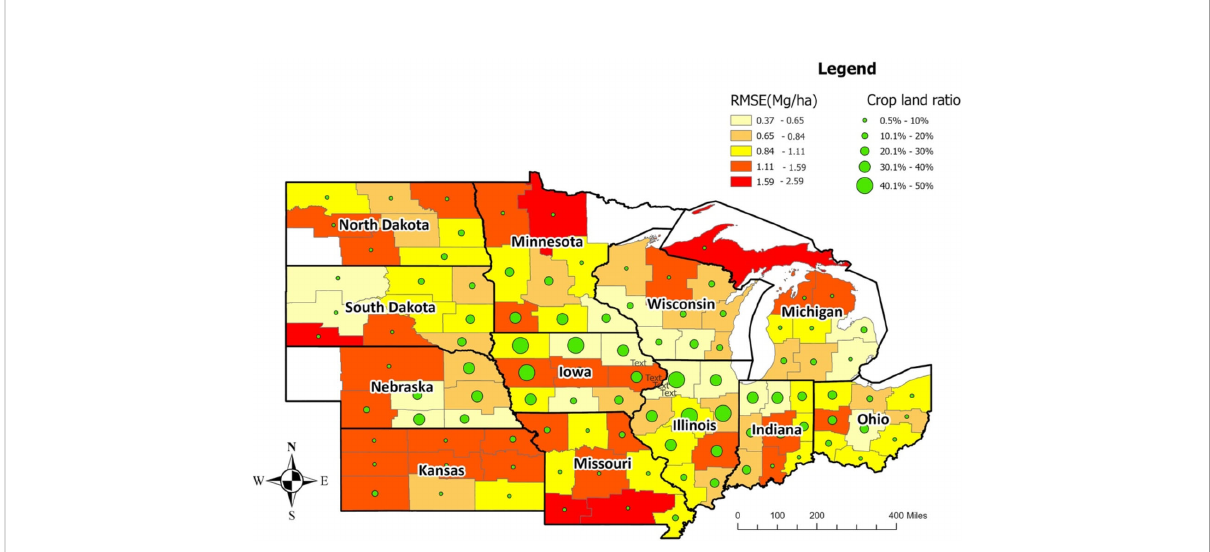
FIGURE 5 Average model performance at CRD level in terms of RMSE (the year 2018-2020). The lighter color corresponds to lower RMSE (ranging from 0.37 to 1.11Mg/Ha), whereas the darker color stands for higher RMSE (ranging from 1.11 to 2.59 Mg/Ha). The green circles provide information on the cropland ratio of the crop reporting districts. Overall, Iowa, Illinois, Indiana, and Ohio have lower prediction